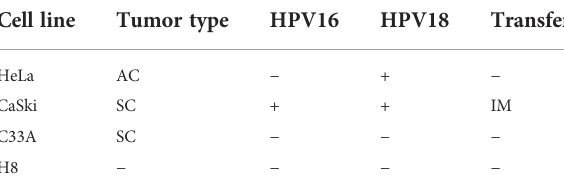
TABLE 1 Molecular classi fi cation of human cervical cancer and epithelial immortalized cell lines. Cell